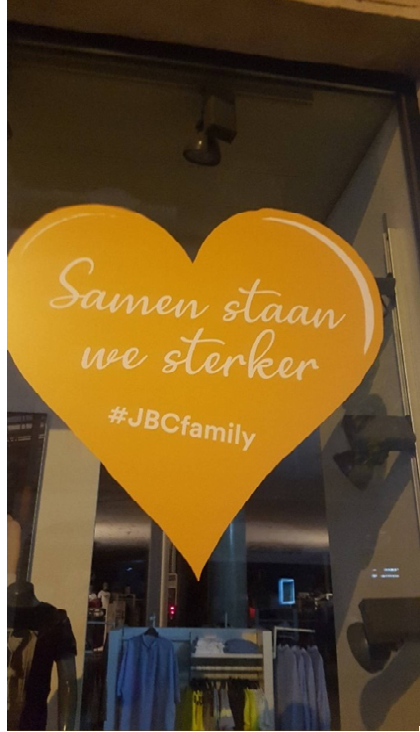
Figure 9. Together we stand stronger.